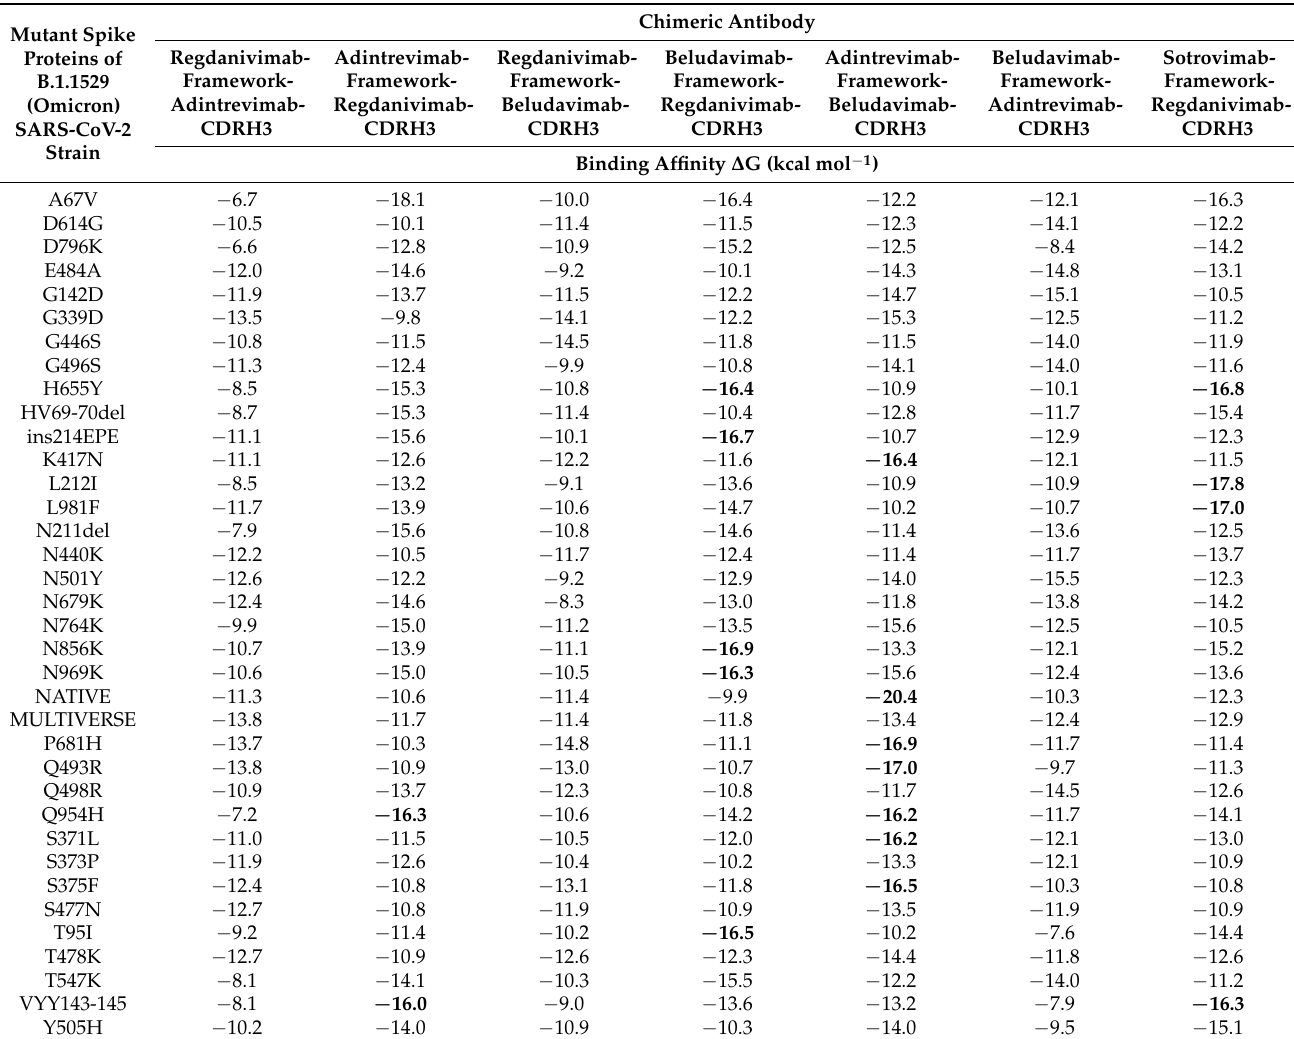
Table 4. Comparative study on the binding affinity of different chimeric mAbs against omicron variants of